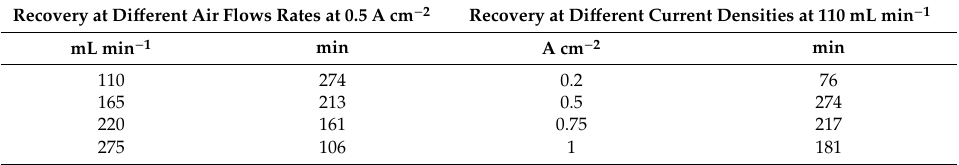
Table 1. Summary of the performance recovery time after introduction of 100 ppm NO 2 to the cathode air flow. Pure H 2 was used at the